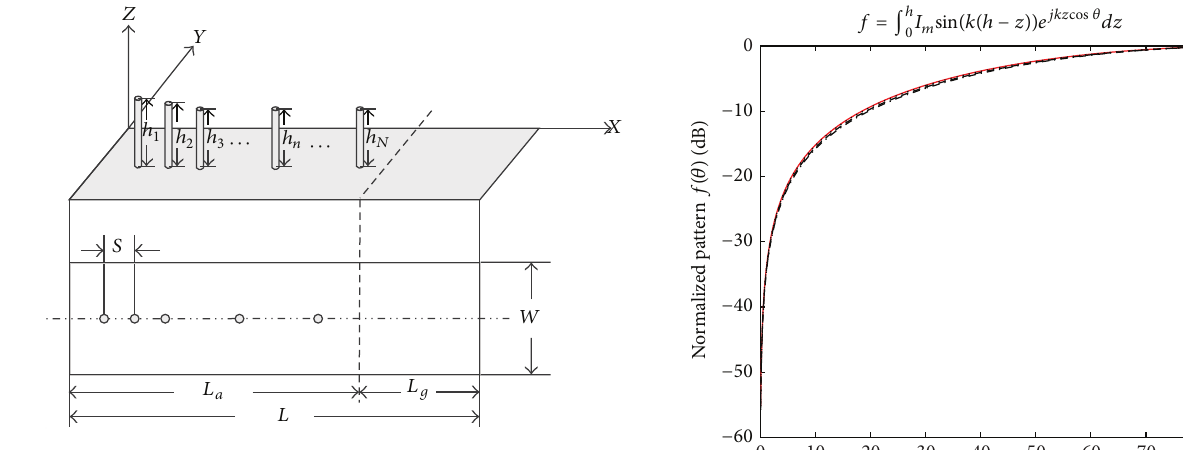
Figure 1: 𝑁 -monopole end-fire antenna vertically mounted on a finite ground plane.